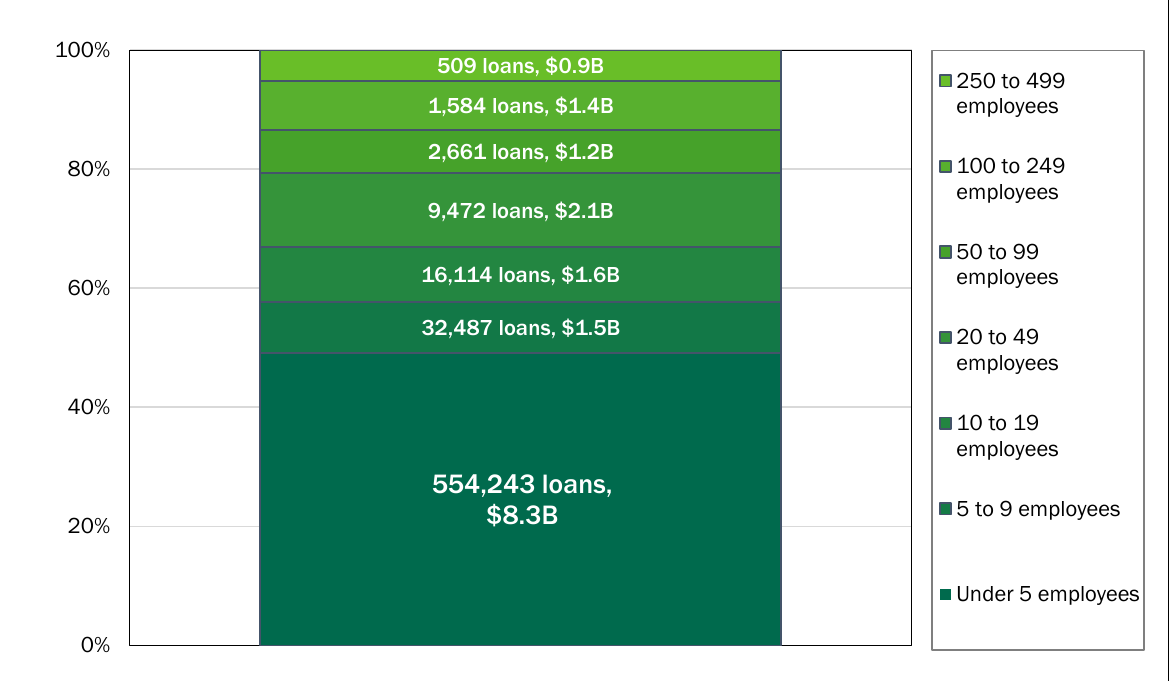
Source: Analysis of 2020 and 2021 PPP data released by SBA on June 1,